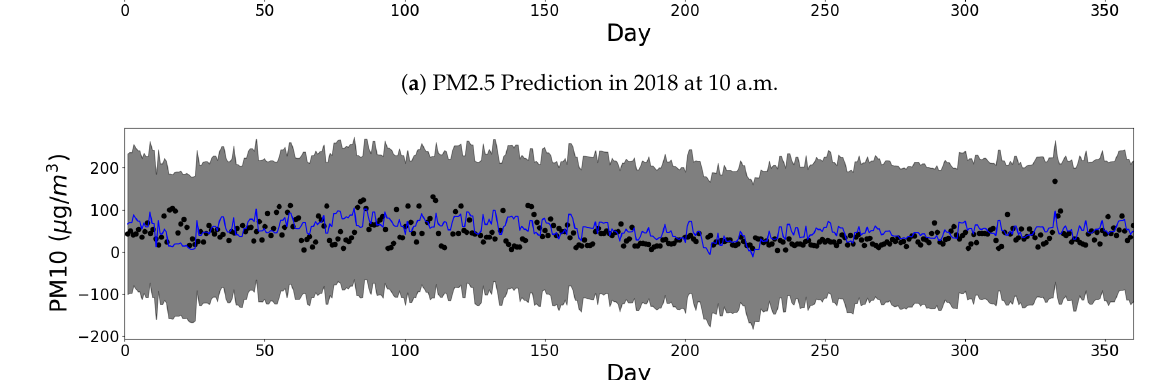
Figure 5. One year prediction results of our GPR model at grid location of (126.835169, 37.544682). (Black dot: observed, Blue line: predicted, Grey area: 95% confidence interval.)